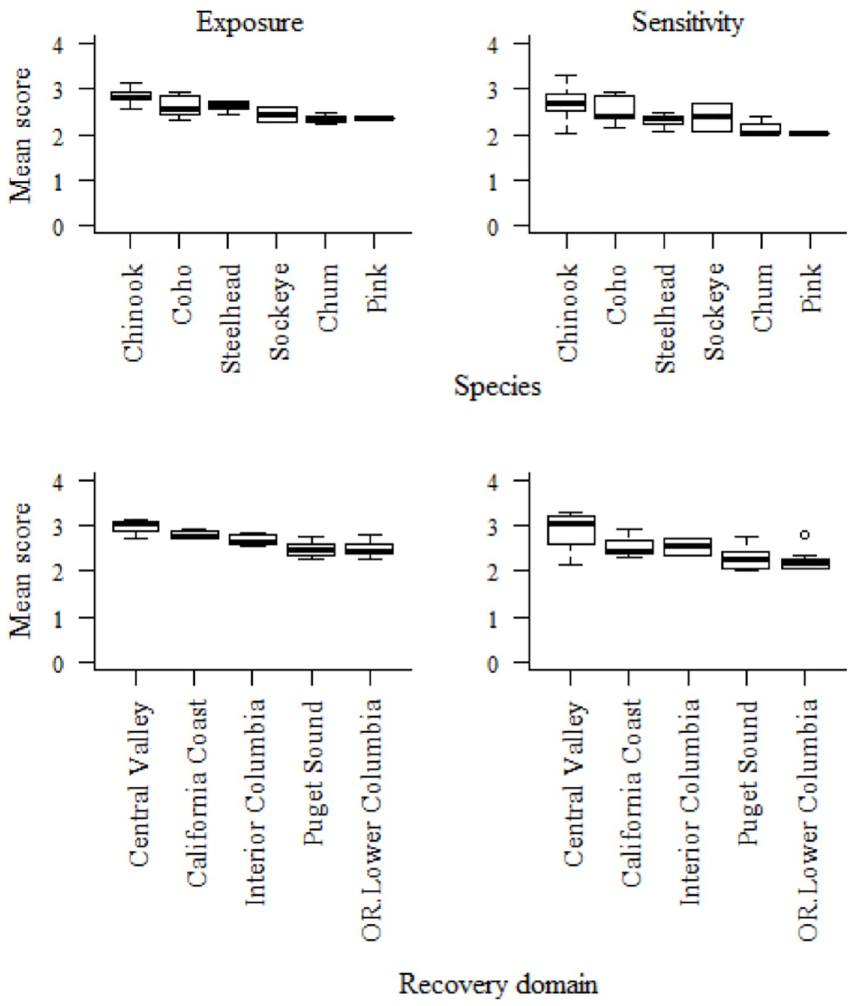
Fig 6. Mean exposure and sensitivity scores by species and recovery domain. Exposure scores are shown at left and sensitivity scores at right by species in upper panels and by recovery domain in lower panels. Because of the small number of DPSs in some domains, in Fig 6 the three recovery domains from southern Oregon to southern California are lumped into a California Coast group, and Oregon Coast is lumped with Lower Columbia. Boxes indicate the interquartile range of the data, whiskers show 1.5 � the interquartile range, and the black line shows the median